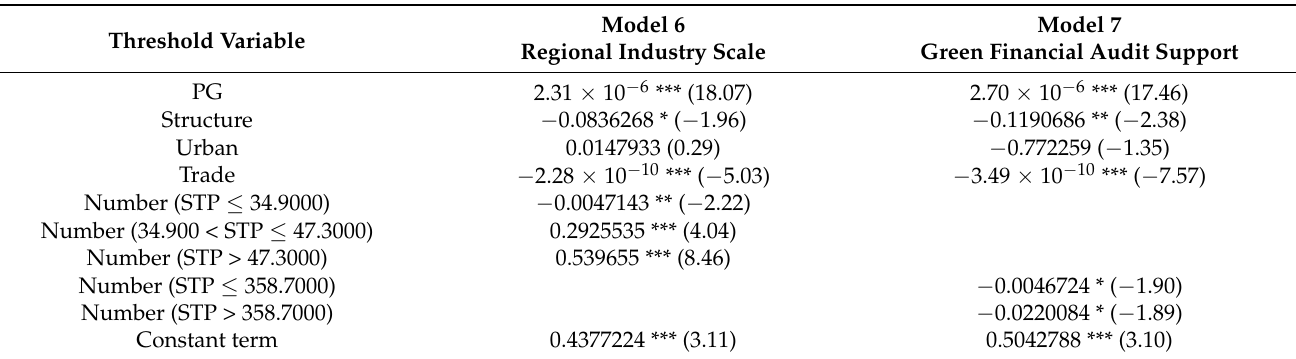
Table 7. Threshold model estimation